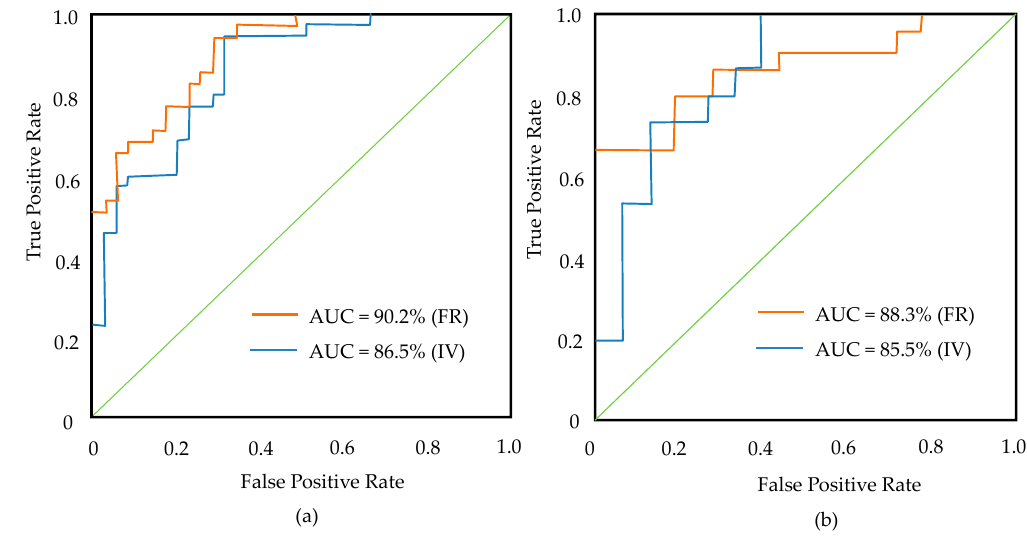
Figure 9. Success and prediction rate curves using the frequency ratio and information value methods: ( a ) success rate curve and ( b ) prediction rate curve.